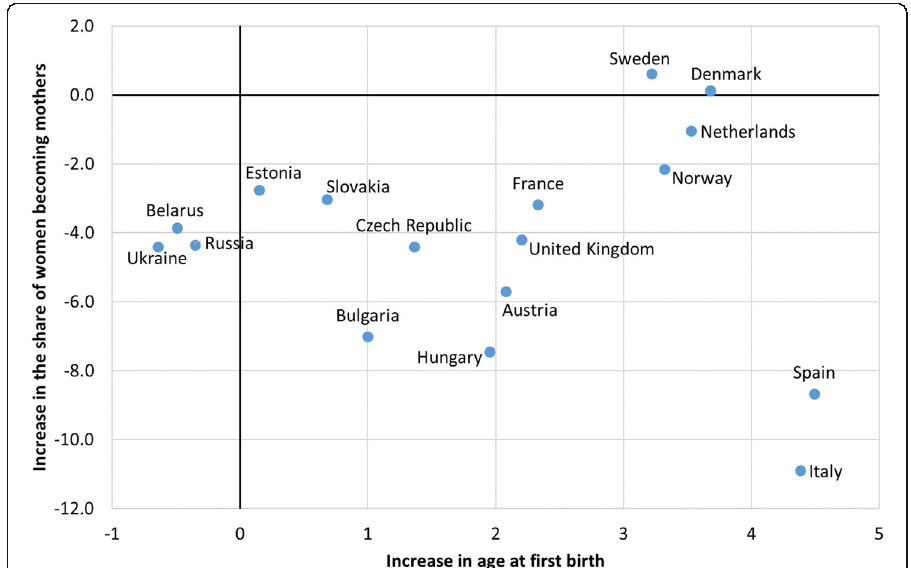
Fig. 7 Changes in the average maternal age at first birth and the proportion of mothers among the 1952 and 1972 cohorts of women. Source: for age at first birth, see Fig. 5; for the proportion of women becoming mothers, Sobotka (2017) and the European Fertility Datasheet (Sobotka et al., 2015). The variation in age at first birth (in years) is shown on the x -axis and the variation in the proportion of women becoming mothers (in %) on the y -axis. Variations are between the 1952 and 1972 birth cohorts